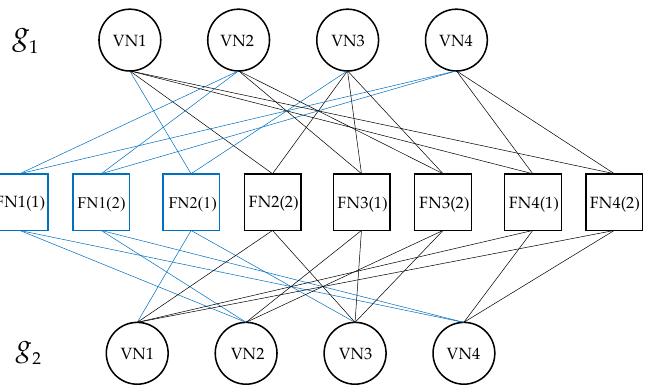
Figure 13. Joint-factor graph with PGA. Figure 13. Joint‑factor graph with PGA.